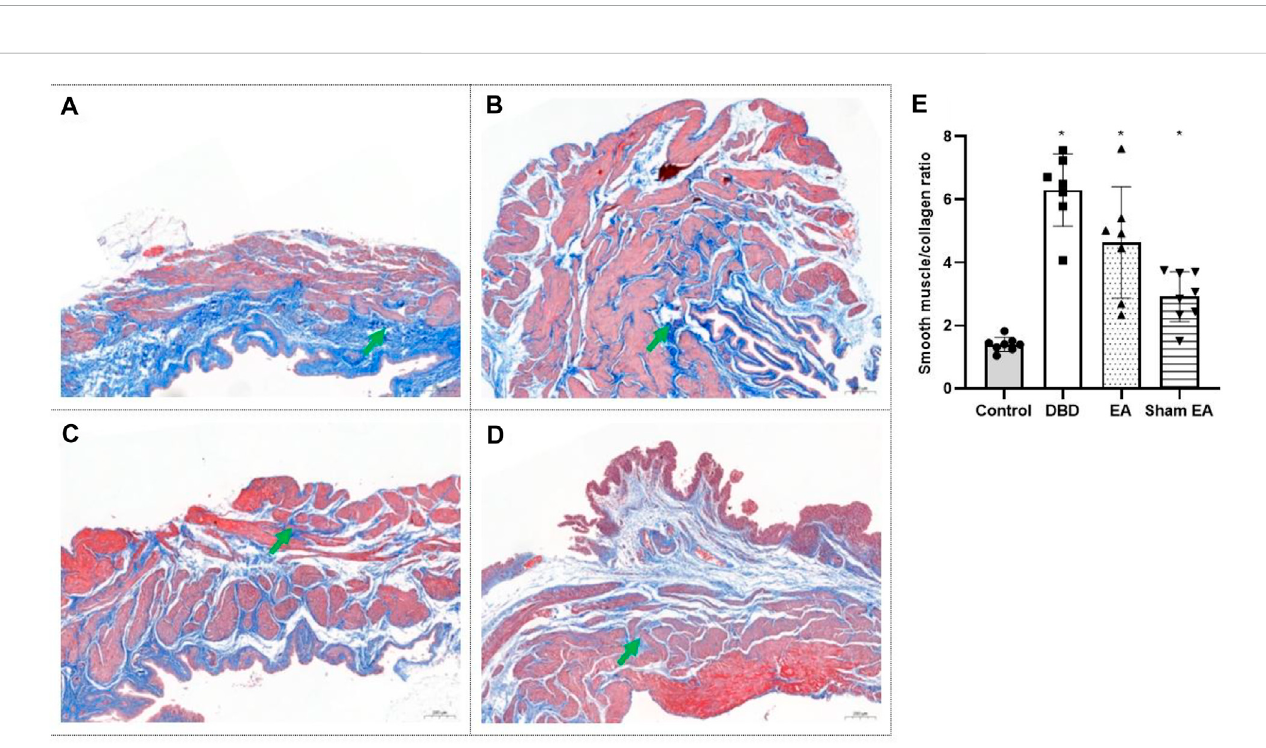
FIGURE 6 The smooth muscle/collagen ratio in each group on Masson ’ s trichrome images. Digitalization images (50x) from Masson ’ s trichrome staining. Representative micrographs show collagen with blue staining and muscle with red staining. (A) . Control group: n = 8 rats; (B) . DBD group: n = 7 rats; (C) . EA group: n = 7 rats; (D) . Sham EA group: n = 8 rats; (E) . The ratio of smooth muscle to collagen in Masson ’ s trichrome staining. Results are expressed as mean ± standard error of the mean. * p < 0.05 versus the Control group (one-way ANOVA). The green arrowheads indicate fi ber